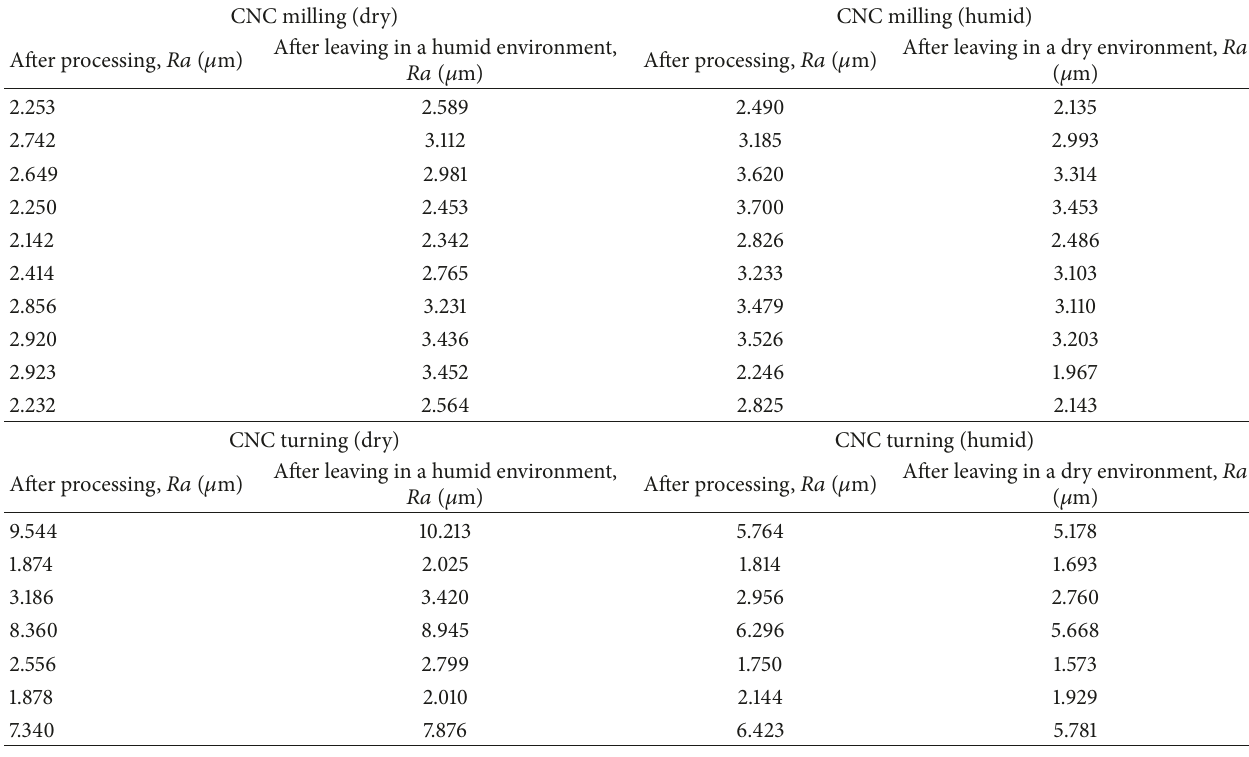
Table 3: The effect of humidity on the change of surface roughness.